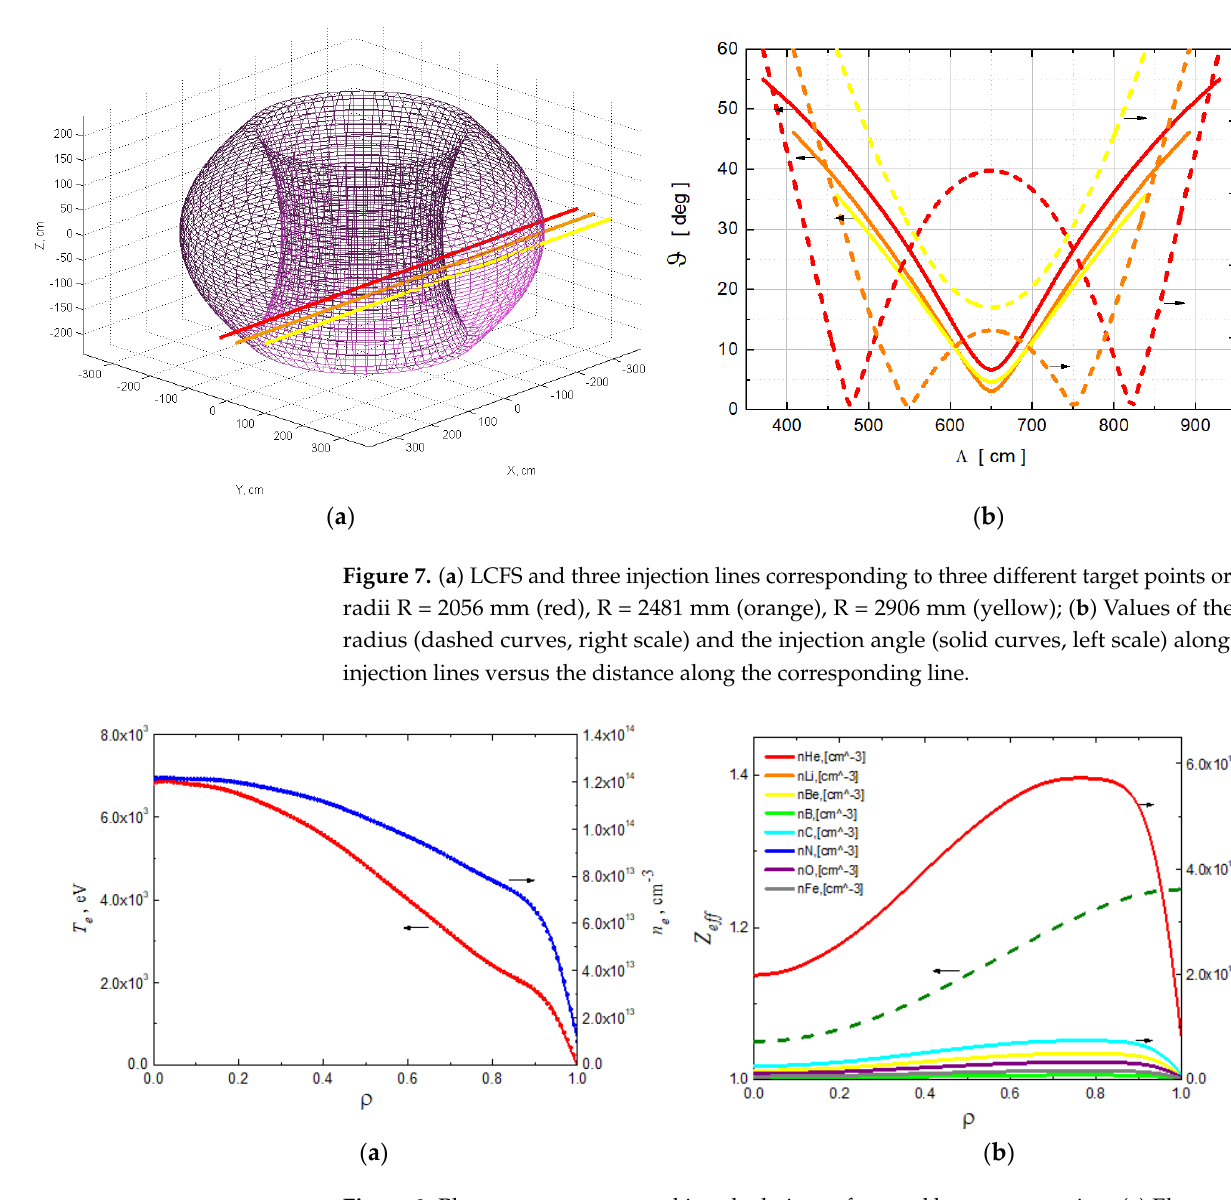
Figure 8. Plasma parameters used in calculations of neutral beam penetration: ( a ) Electron temperature (red curve, left scale) and electron density (blue curve, right scale); ( b ) Effective charge (dashed curve, left scale) and impurity ion densities (solid curves, right scale).